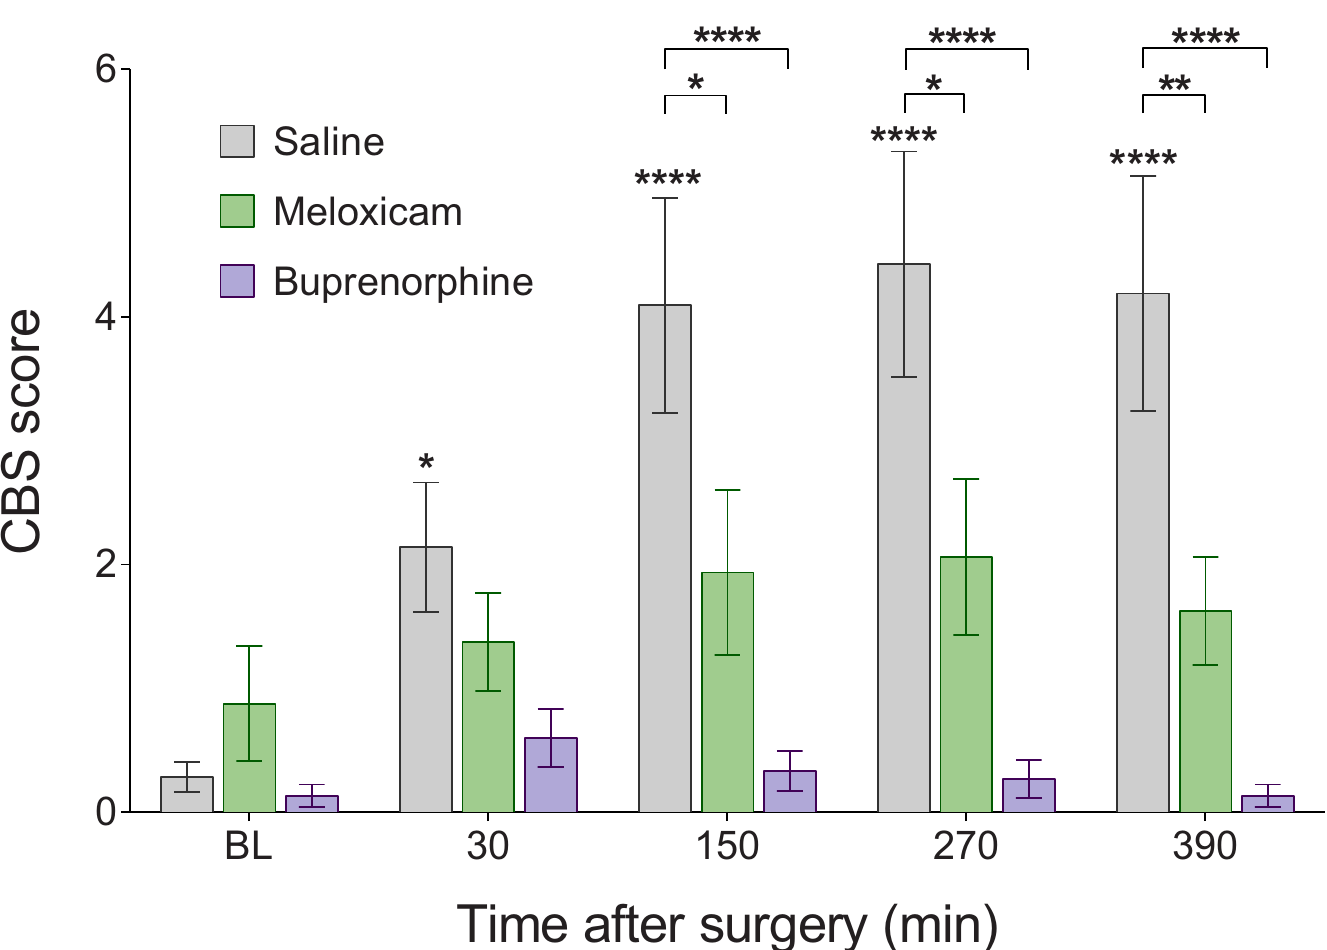
Fig 2. Composite behaviour scores (cumulative frequency of back-arching, writhing and staggering) are reduced by both meloxicam and buprenorphine following laparotomy. Saline (n = 21), meloxicam (n = 16) and buprenorphine (n = 15) groups at all time points. Data presented as mean ± SEM. BL = baseline. Asterisks stars above bars indicate within group differences from baseline. Asterisks with brackets indicate differences between groups.